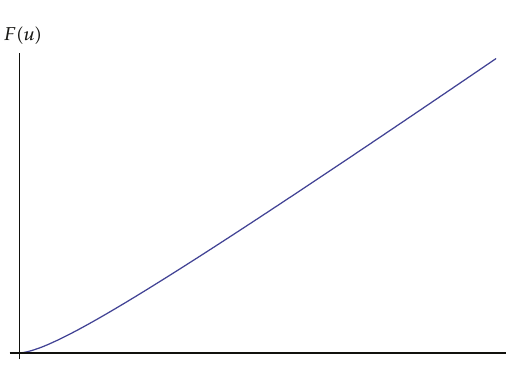
Figure 4: Graph of F (cid:4) u (cid:5) when β (cid:3)